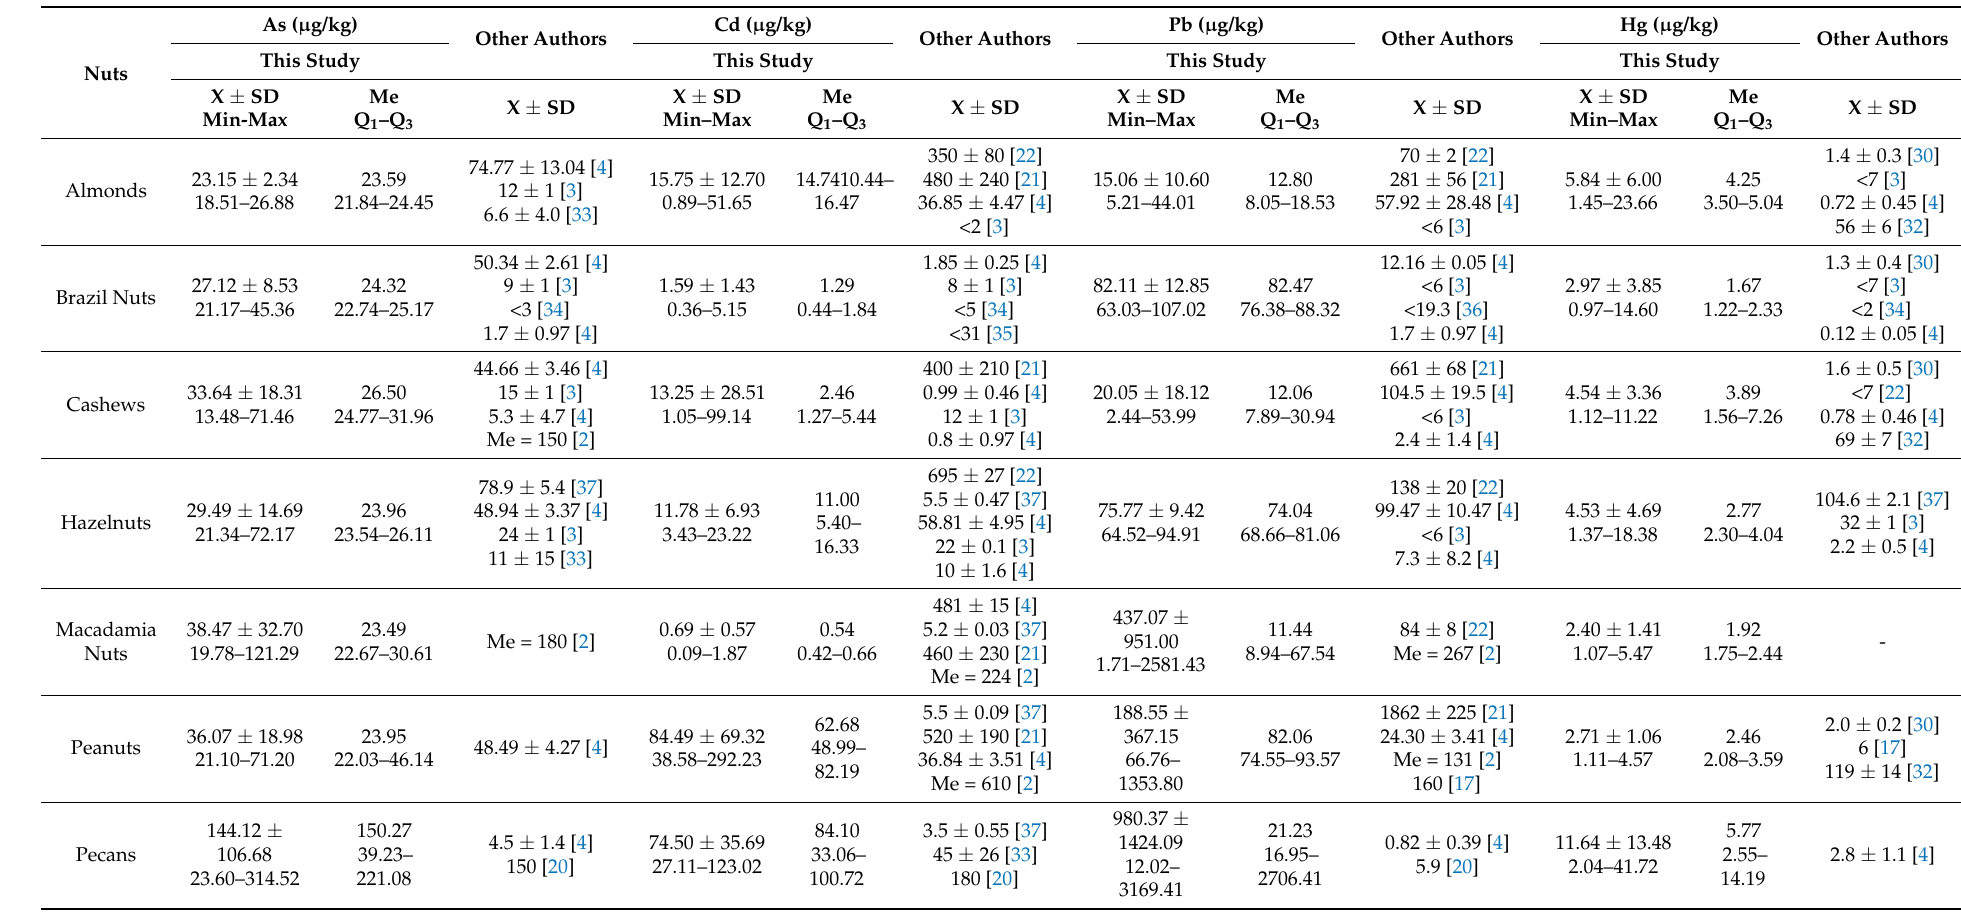
Table 1. Content of toxic elements in nuts in this study and determined by other